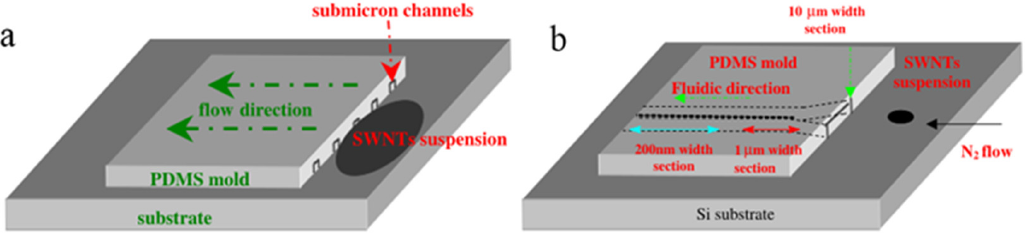
Figure 7. ( a ) Schematic representation of SWNT alignment by the capillary effect. Adapted with permission from [66], Copyright 2006 IOP Publishing. ( b ) improved method with funnel-shaped entrances and N 2 flow. Reproduced with permission [67]. Copyright 2007, IOP